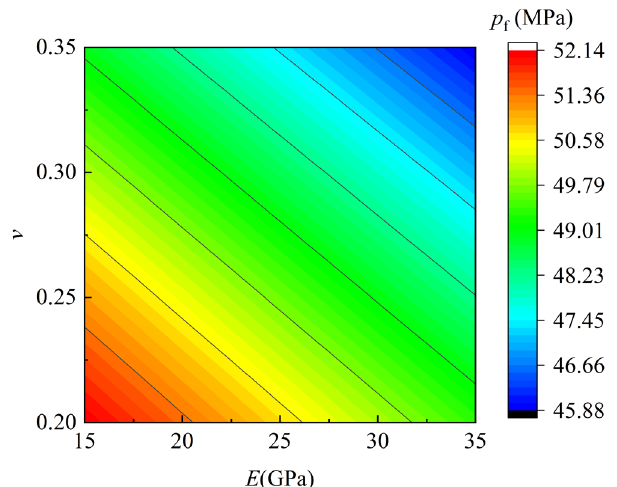
Figure 9. Effect of Poisson’s ratio and elastic modulus on initiation pressure.